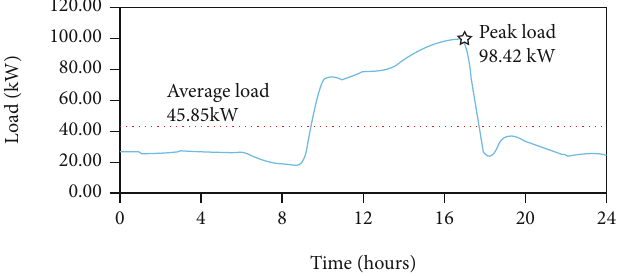
Figure 2: Daily load pro fi le of ACGCET campus.